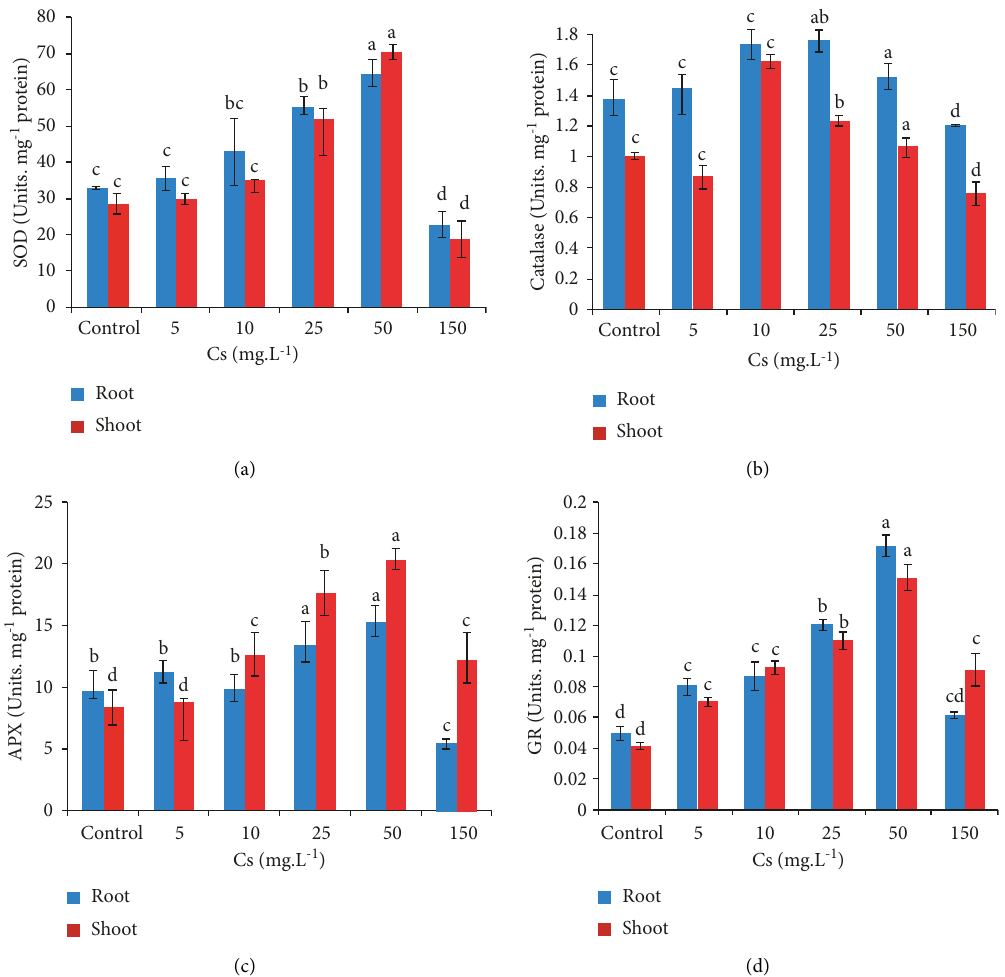
Figure 5: Effect of cesium on antioxidant enzymes activity of S. portulacastrum : (a) superoxide dismutase (SOD), (b) catalase (CAT), (c) ascorbate peroxidase (APX), and (d) glutathione reductase (GR). All the values are mean of twelve readings ± S.E. One-way ANOVA significant at p ≤ 0.05. Different letters indicate significantly different values of antioxidant enzymes (DMRT p ≤